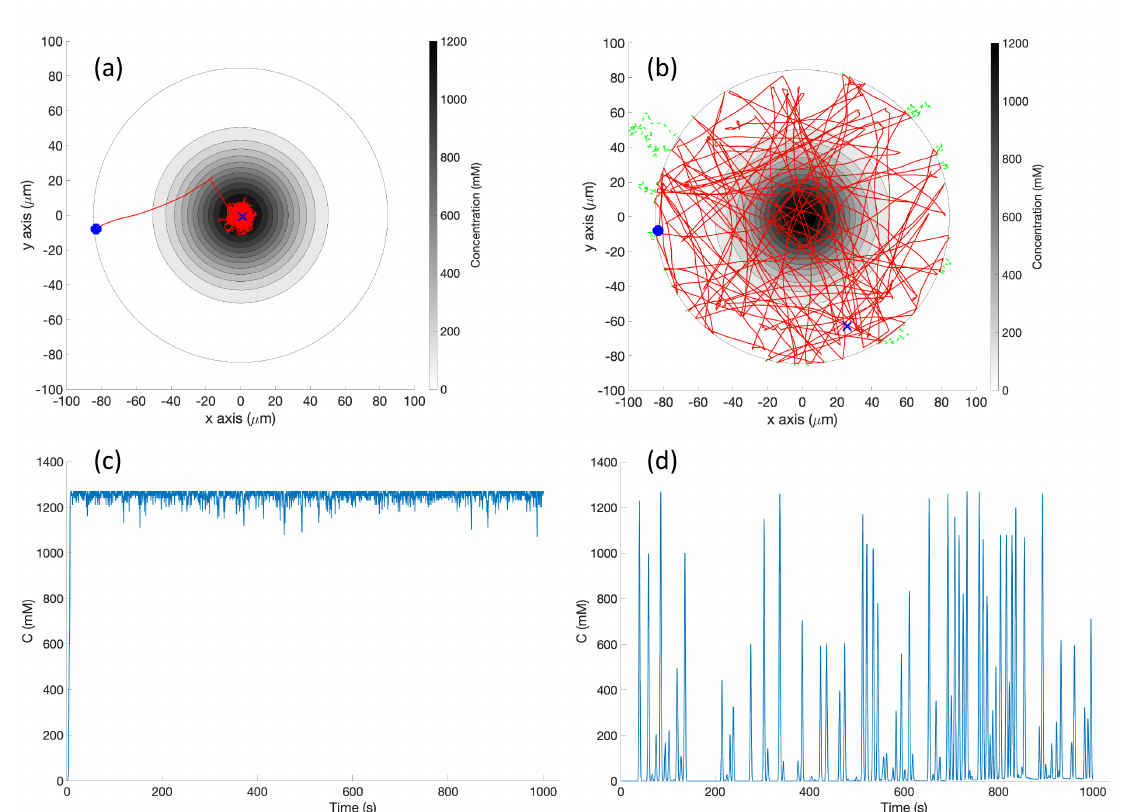
Figure 11. Case 2: Without obstacles, in the single-effluent environment, typical trajectories of the simulated robot running ( a ) the basic chemotaxis controller, and ( b ) the RapidCell chemotaxis controller. The contour plot represents the concentration distribution shown in Figure 3 (left) where the outmost level curve represents the concentration at 1m M . In each trajectory, the initial position is shown as a blue circle and the terminal position is shown as a blue “X”. Positions corresponding to concentrations less than 1m M are shown in dashed green, otherwise shown in red. The recorded concentrations associated with each scheme are shown in ( c , d )